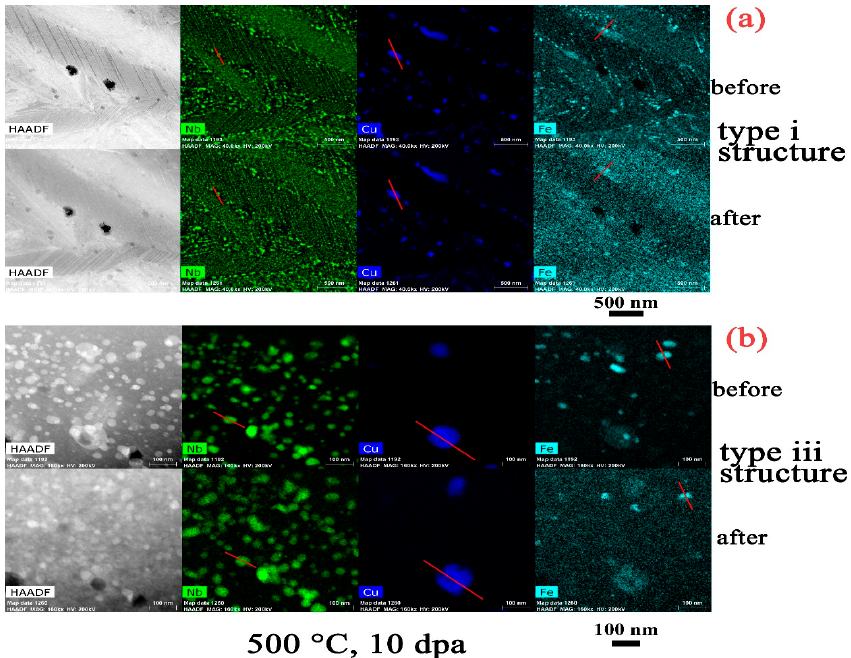
Figure 5. HAADF and Chemi-STEM micrographs showing the distribution of Nb, Cu, and Fe alloying elements before and after heavy ion irradiation at 500 °C to 10 dpa in ( a ) type i and ( b ) type iii structures. Red lines in the maps indicate the precipitates used for the element distribution line profile measurement.